Question: What style of plot is this figure drawn as?
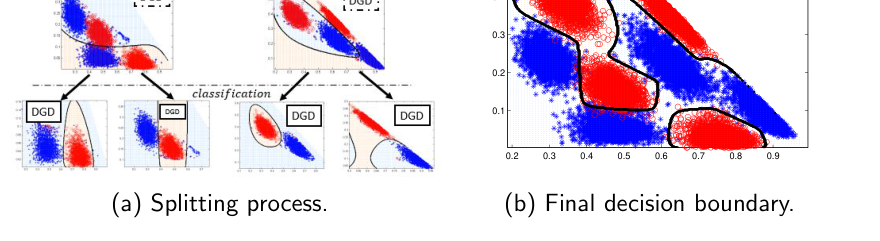
Answer: line